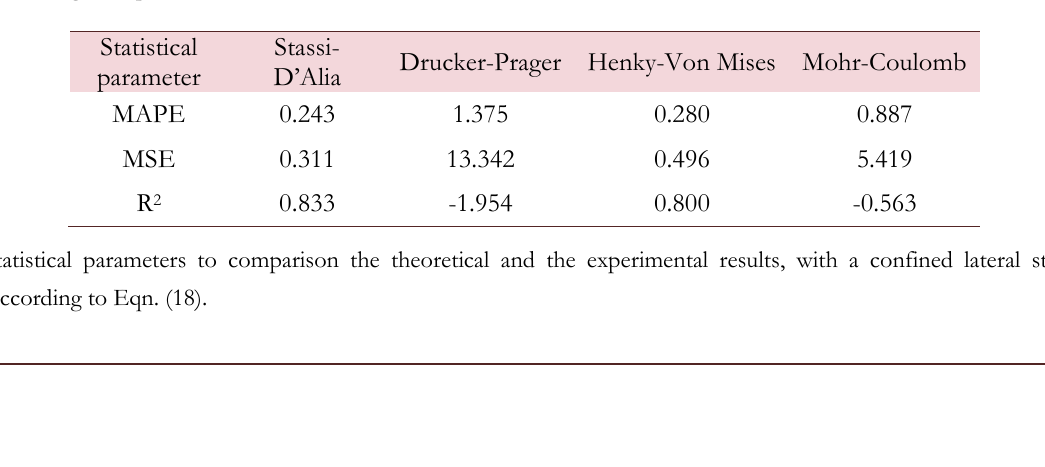
Table 3: Statistical parameters to comparison the theoretical and the experimental results, with a confined lateral stresses, calculated according to Eqn.